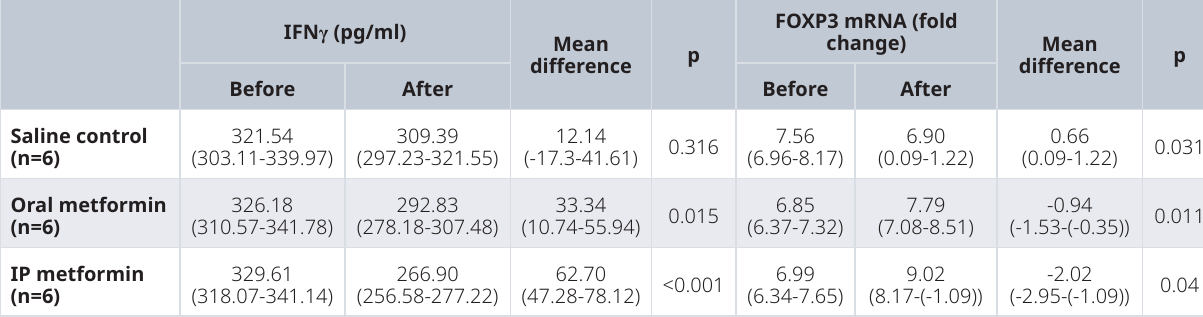
Table 2. Comparison of IFN γ levels and FOXP3 mRNA expression before and after intervention with metformin in pristane- induced BALB/C mice. Data are presented as mean (95% confidence interval).